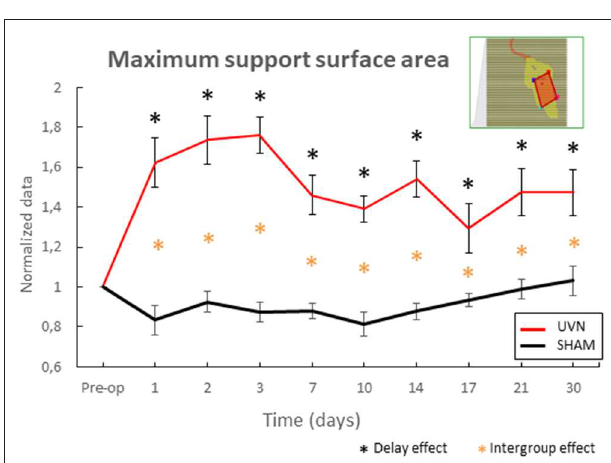
FIGURE 5 | Automatic quantification of the maximum support surface area, a biomarker of postural instability. This parameter reveals instability following surgery in the NVU group at critical and compensated periods. Note that from the first post-lesion day to the last acquisition day, the maximum value of the support surface area of the sustentation polygon increases significantly in the UVN group compared to the preoperative time (0.05 < p < 0.0001), and compared to the SHAM group (0.05 < p < 0.0001). Standard errors of the mean are reported as vertical lines. Delay effect refers to significative differences with the preoperative condition; intergroup effect means that a significative difference was found between UVN and SHAM group (* p <